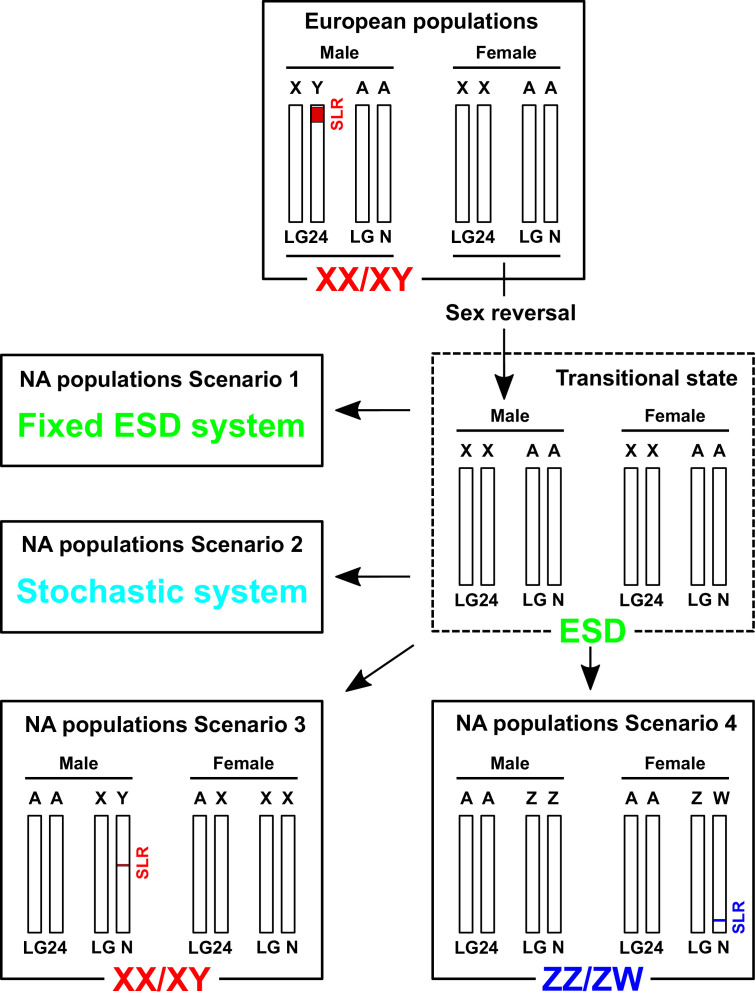
Hypothesized scenarios of sex determination system transition in North American populations of E. lucius.In the ancestral population, Linkage group 24 (LG24) was the sex chromosome (Y). Males were the heterogametic sex carrying one Y chromosome with a small (~300 kb) sex-locus region (SLR) containing amhby and one X chromosome without the SLR and amhby, while females carried two X chromosomes. During post-glaciation re-colonization of North America, the Y chromosome with amhby gene was not carried by individuals that made up the small populations that dispersed out of Alaska. These populations could still produce phenotypic males in the absence of a master sex determining gene via environment-induced sex reversal, a well-documented phenomenon among teleosts. In this transitional state, both males and females carry two X sex chromosomes (LG24). The current sex determination mechanism in these North American populations is still unknown: it could rely entirely on environmental sex determination (ESD), random sex determination, or new male (XY) or female (ZW) heterogametic genetic sex determination system with highly undifferentiated sex chromosomes. SLR: sex-locus region. ESD: environmental sex determination. NA: North America. LGN: un-specified Linkage group, that is ancestral autosomes (A) that are not LG24.